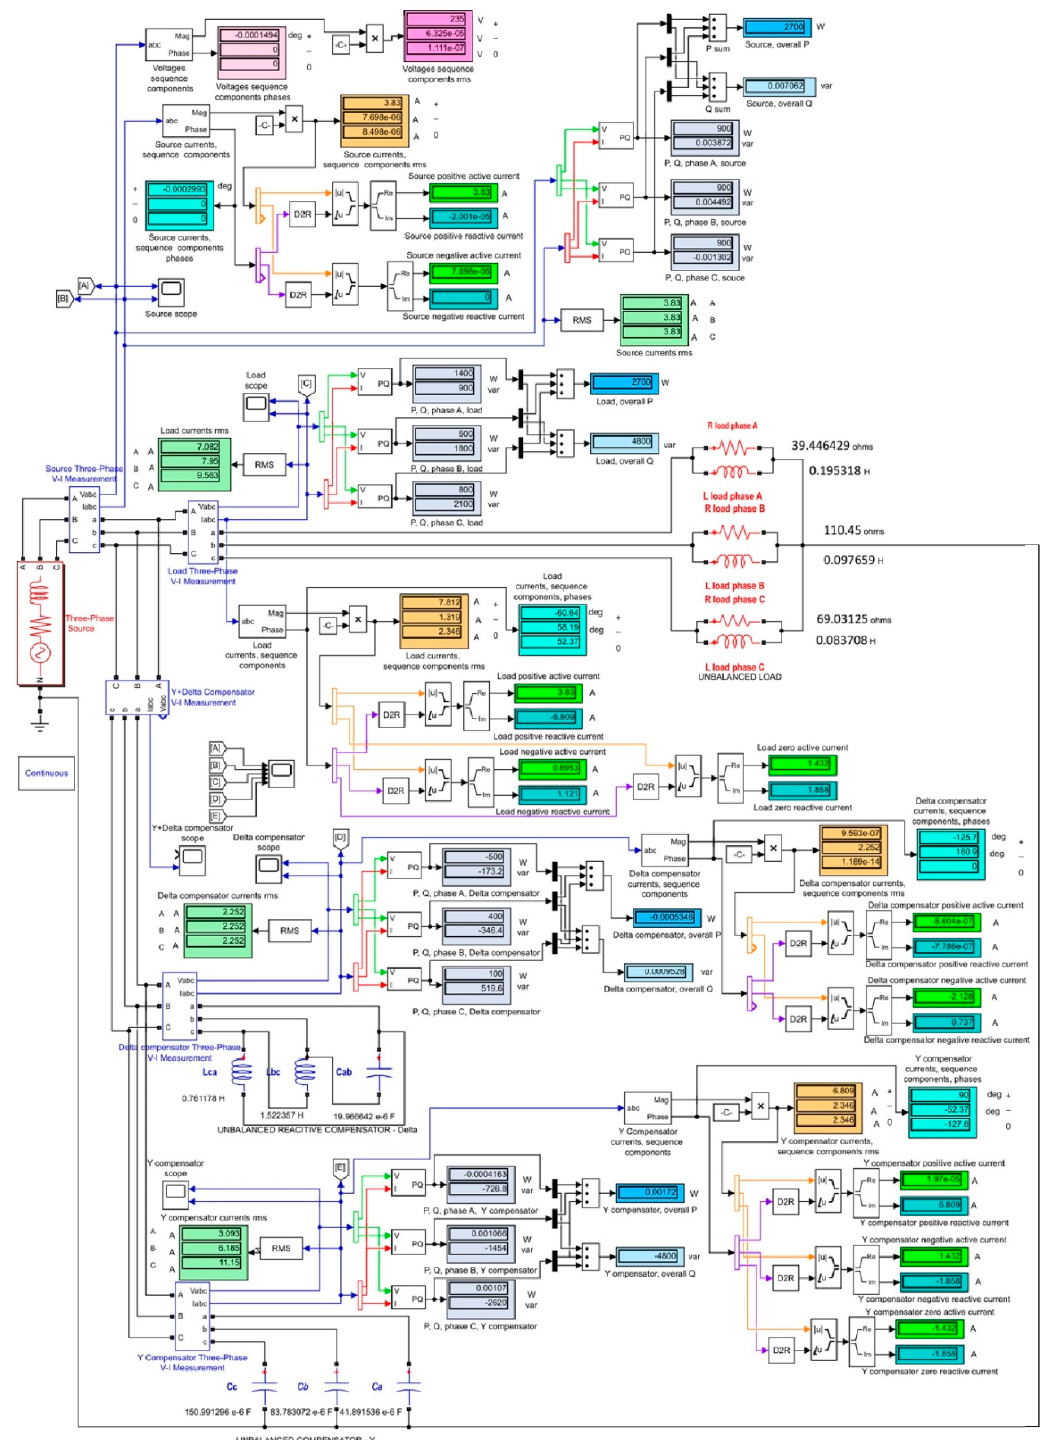
Figure 4. The Matlab model used to study the BRC operation considered in the case study.